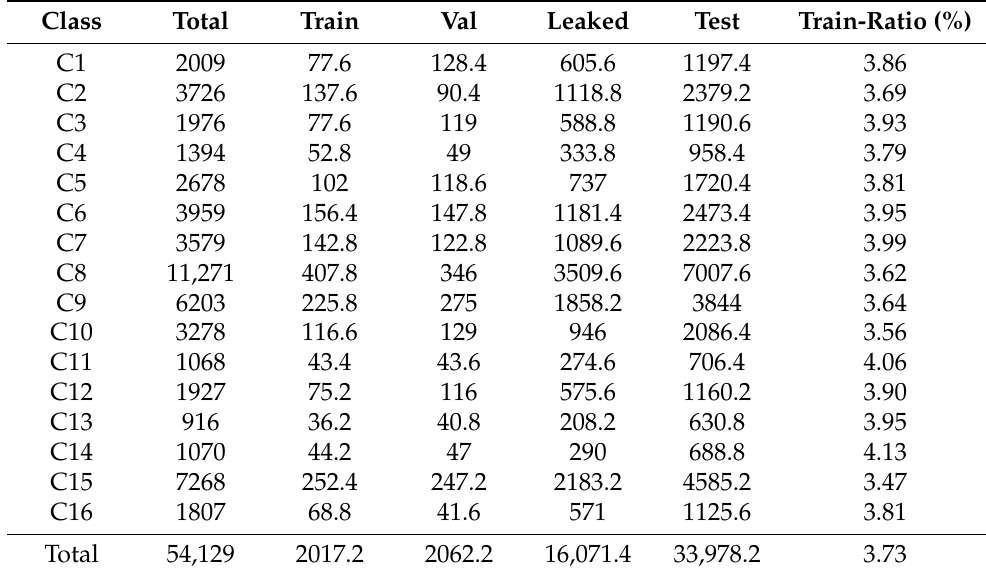
Table 1. Average number of training/validation/leaked/test pixels in Salinas Valley.